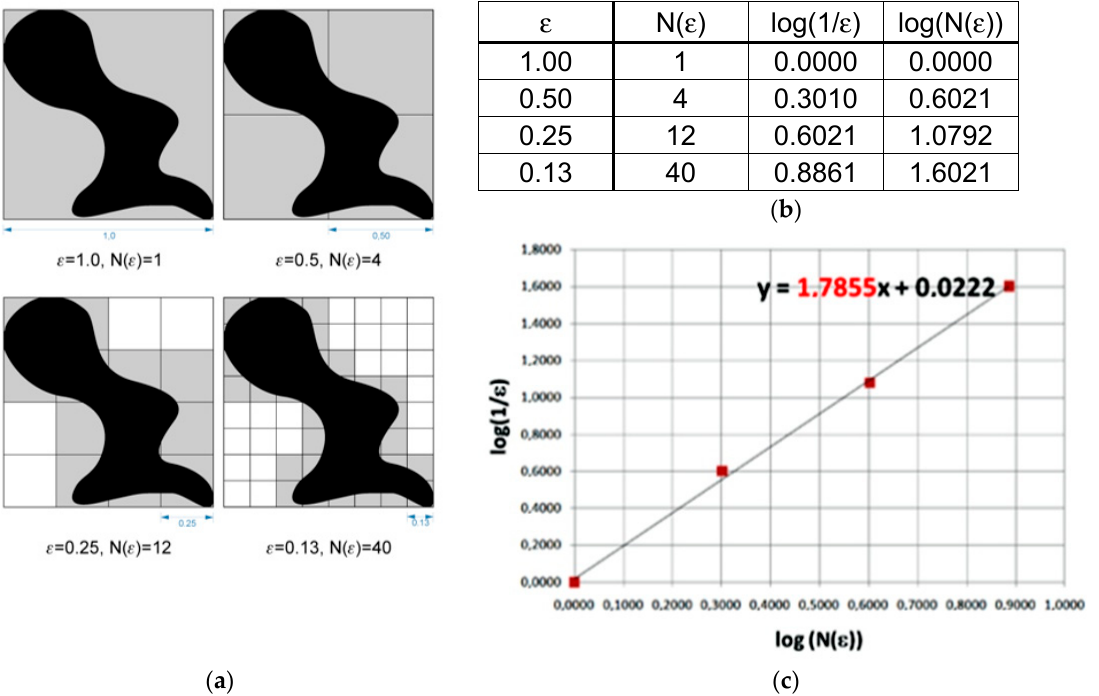
Figure 6. Graphical interpretation of the counting box method for fractal dimension measurement.